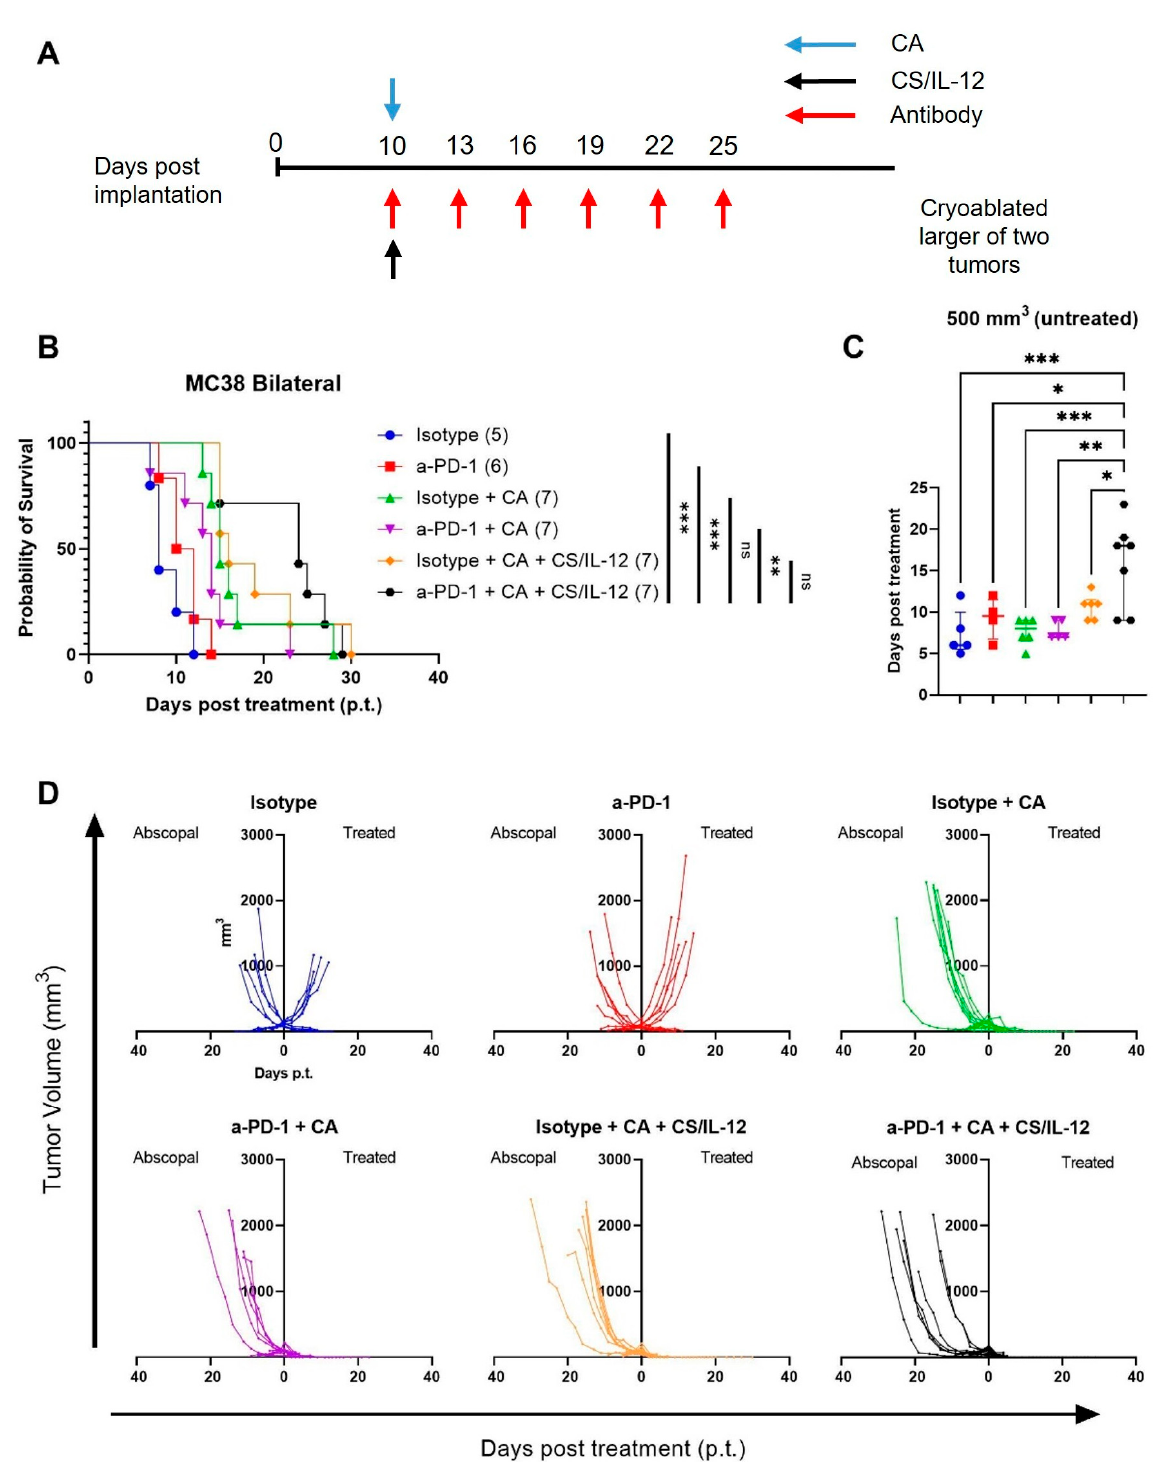
Figure 7. Addition of checkpoint inhibitors to CA + CS/IL-12 delays abscopal tumor growth. In the MC38 model, bilateral tumors were implanted on the right and left flanks and the larger of the two tumors was treated when it reached between 150 and 200 mm 3 . ( A ) Antibody treatment (300 µg) with either anti-PD-1 or isotype control began on the same day as CA and was delivered i.p. every 3 days for a total of 6 doses. Survival ( B ) and tumor volume ( D ) were monitored for 30 days post treatment. The number of days post treatment for the abscopal tumor to reach 500 mm 3 ( C ) was calculated as the fi rst day the contralateral tumor measured ≥ 500 mm 3 . The number in parentheses next to the legend label for each group indicates the number of mice in that treatment group ( B ). Statistical signi fi cance was calculated using the Log-rank (Mantel–Cox) test ( B ) and a one-way